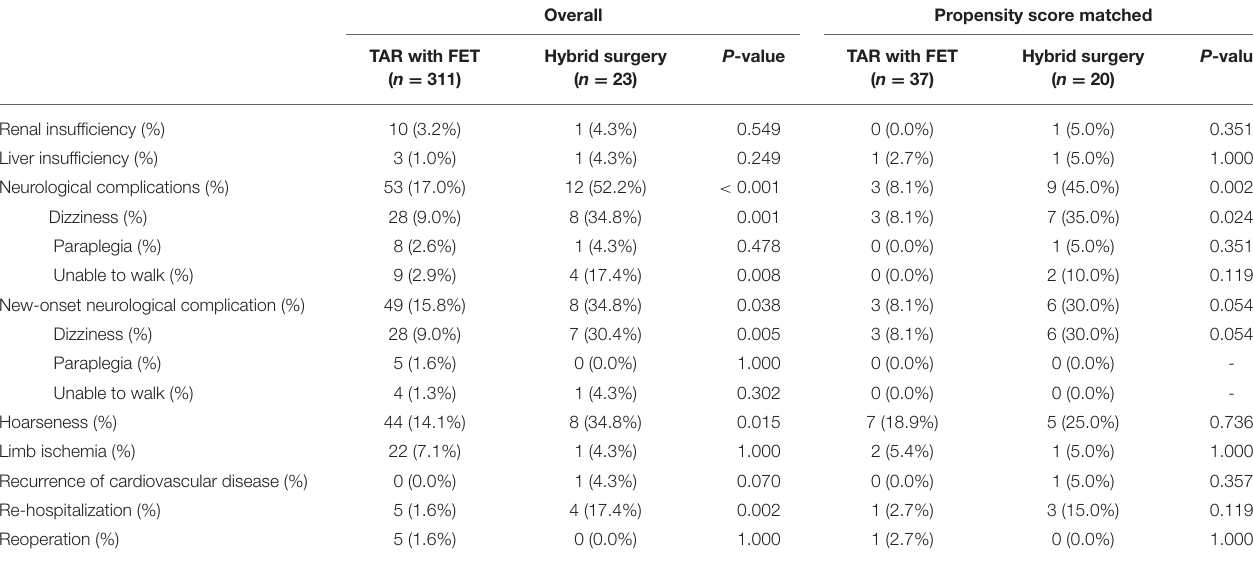
TABLE 4 | Mid- and long-term prognosis and follow-up results.